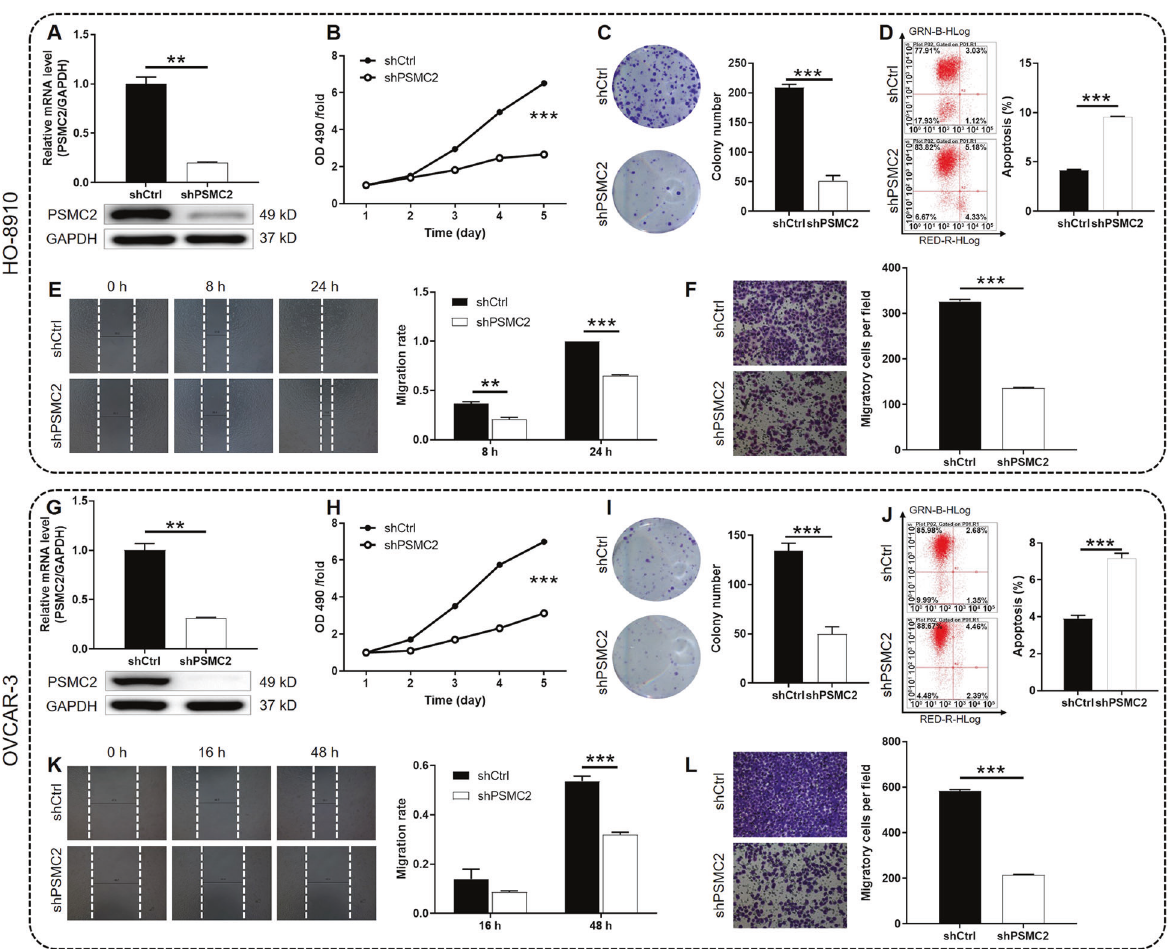
Fig. 2 Knockdown of PSMC2 inhibits ovarian cancer development in vitro. A ,, G qPCR and western blotting were used to con fi rm the construction of PSMC2 knockdown ovarian cancer cell lines. B , H The effects of PSMC2 on cell proliferation were evaluated by MTT assay. C , I The colony formation ability of shPSMC2 and shCtrl cells was assessed by colony formation assay. D , J The percentage of apoptotic cells was determined by fl ow cytometry assay. E , K Wound-healing assay was performed to show the cell migration ability of ovarian cancer cells transfected with shPSMC2 or shCtrl. F , L Transwell assay was carried out to show the cell migration ability of ovarian cancer cells transfected with shPSMC2 or shCtrl. Data were presented as mean ± standard deviation based on at least 3 independent experiments. ** P < 0.01, *** P <